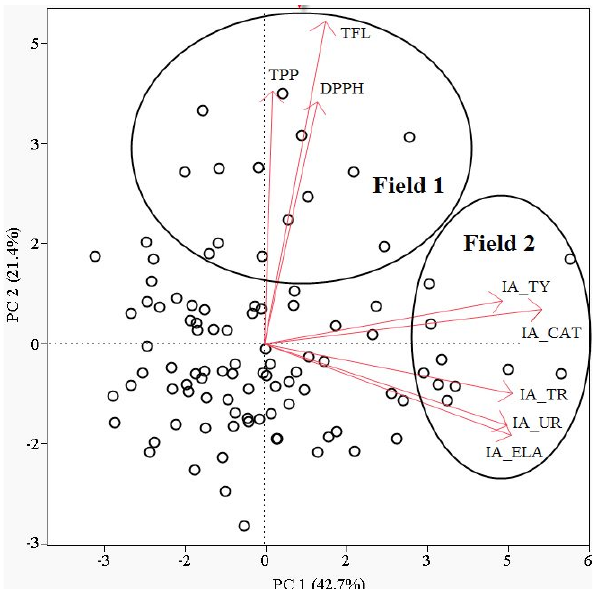
Figure 1: Principal component analysis of composite variables total polyphenols, total flavonoids (TPP, TFL), and activity variables radical scavenging ability (DPPH), protease inhibitory activities to trypsin (IA_TY), thrombin (IA_TR), urokinase (IA_UR), elastase (IA_ELA), and cathepsin B (IA_CATB) detected in seed extracts